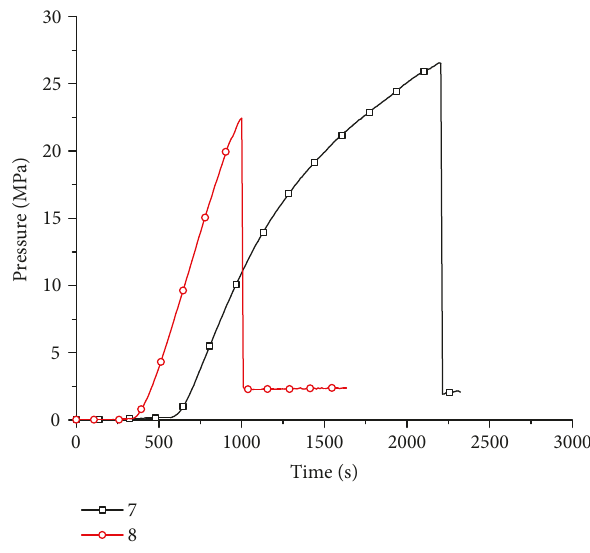
Figure 22: Pressure curves in the core fracturing